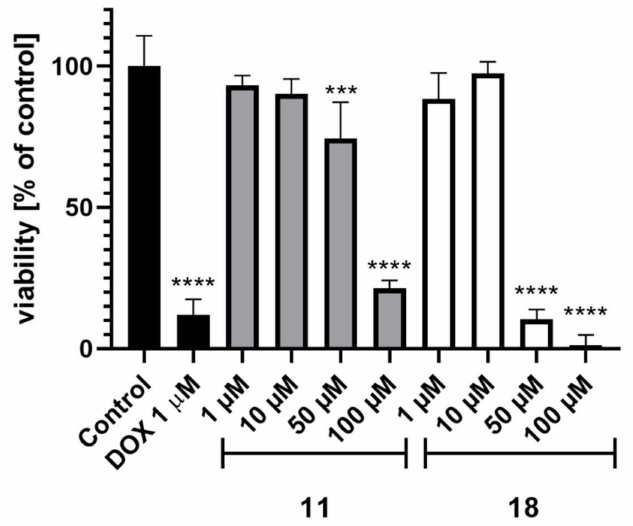
Figure 8. The viability of the HEK-293 cell line after incubation with compound 11 or 18 for 72 h. DOX—doxorubicin. Control—1% DMSO in the cell culture media. The statistical significance was evaluated by a one-way ANOVA, followed by Bonferroni’s comparison test (*** p < 0.001, **** p < 0.0001 compared to